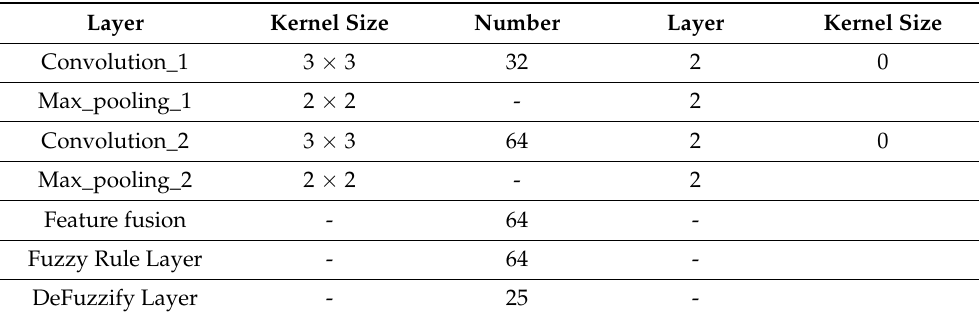
Table 3. Network architecture parameter settings of the CFNN.